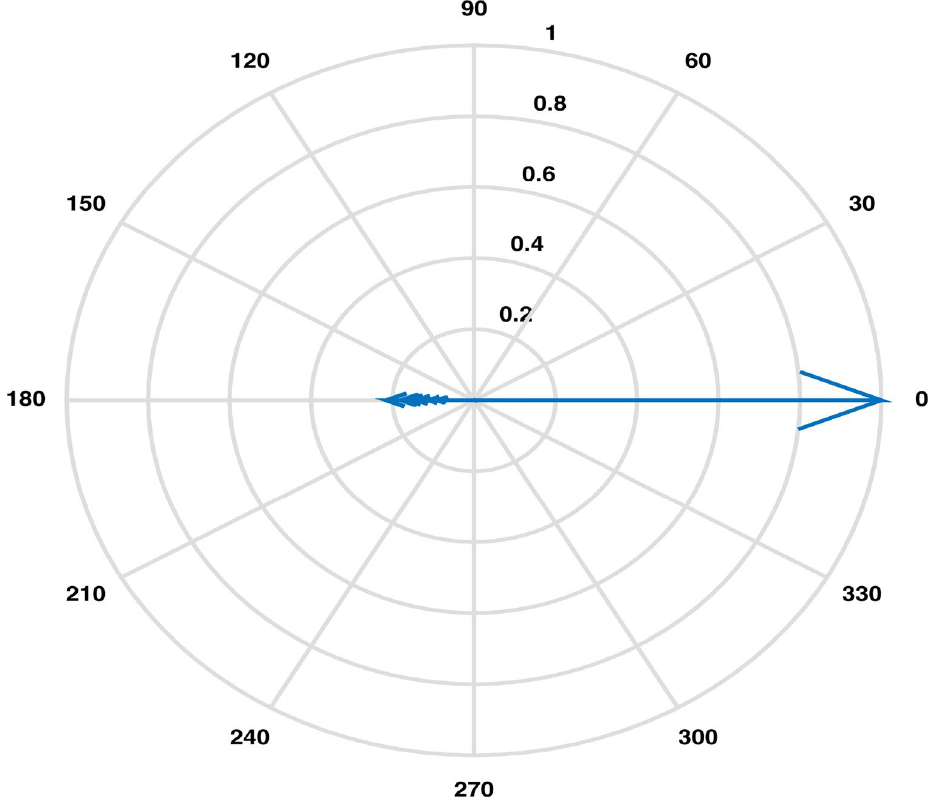
Figure 7. Pairwise correlations of total coliforms with other